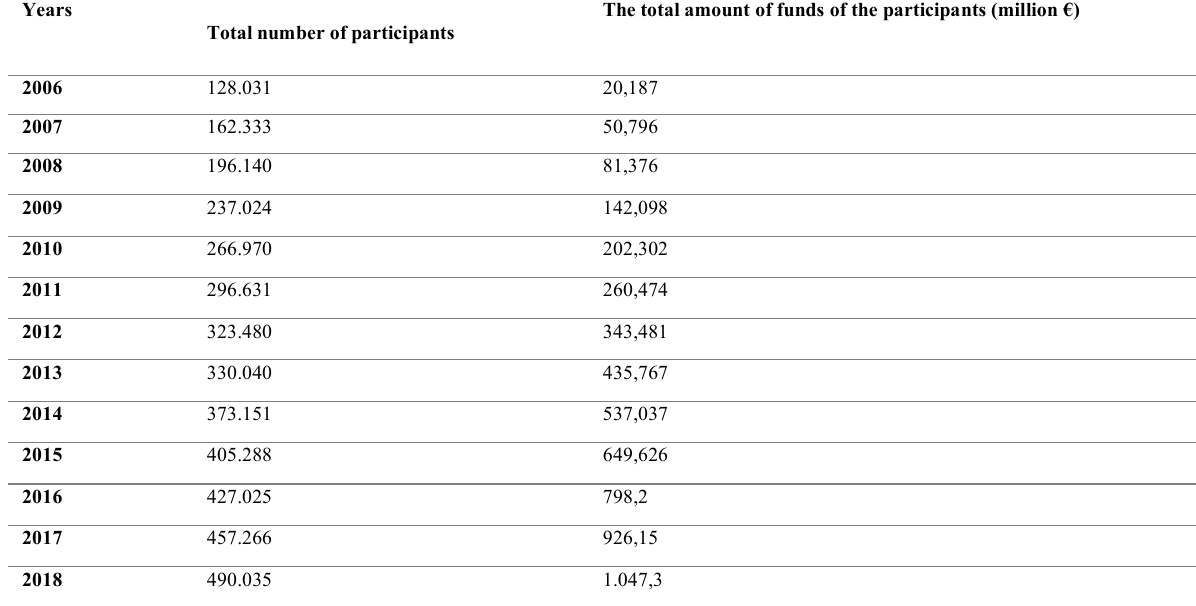
Table 2: Total number of participants and total fund number of participants in the mandatory private pension